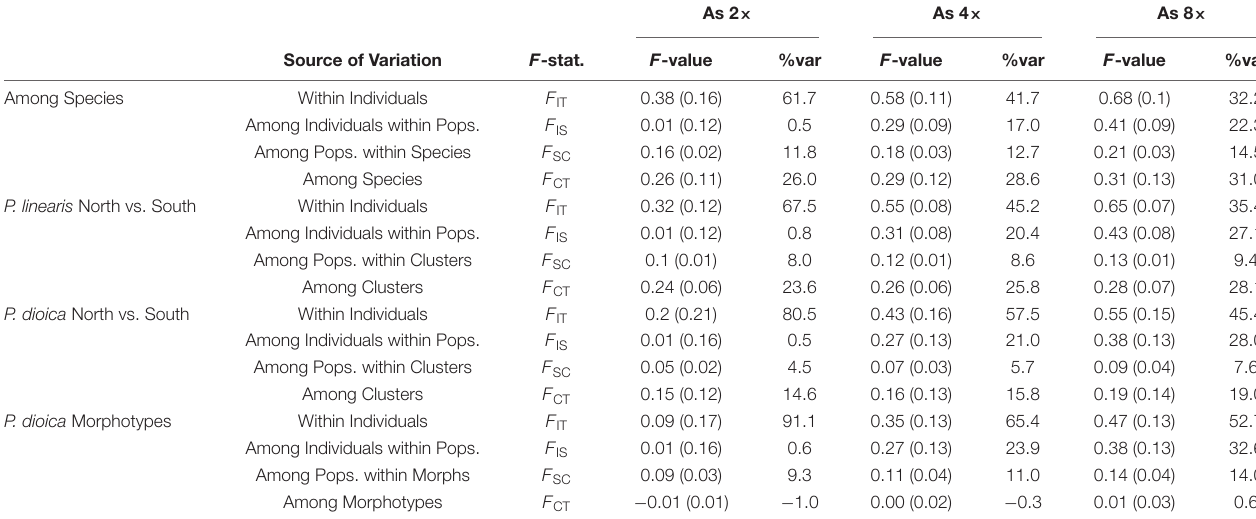
Values of the F-statistics corresponding to the different hierarchical levels of the population structure, and the associated percentages of the total genetic variance (%var). The population structure was based on the results of the S TRUCTURE analyses ( Figures 4 , 5 ), both for delimiting the two species, and for assigning populations to the North and South clusters within species. To avoid circularity, no P-values were calculated (Meirmans, 2015). Following the Structure results, the cryptic Winter form of P. dioica was included in the southern cluster of that species, except for the final AMOVA. There, only P. dioica was included where one cluster was composed of the Winter form and a second cluster was composed of all other populations, in order to test for possible differentiation between the two morphotypes.